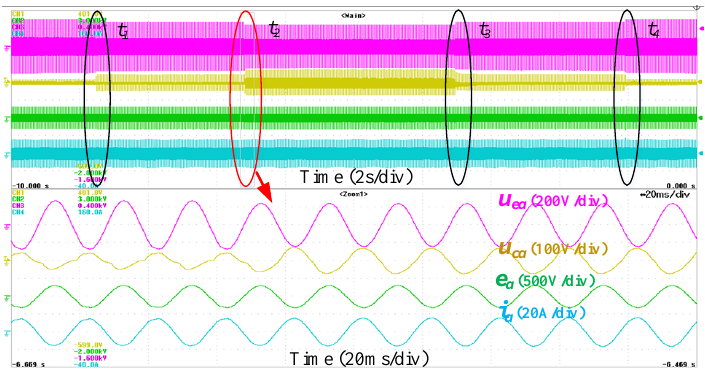
Figure 24. Voltage regulation waveform of the series